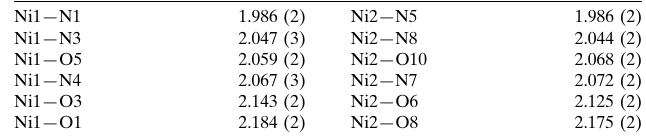
parameter ratio = 14.2. The asymmetric unit of the title compound, [Ni(C H N )(H O)] (cid:1) 1.25H O, contains two independent chemi- (C 10 8 2 2 2 cally identical Ni II complex cations and two and a half solvent water molecules. The Ni II ions are in slightly distorted coordination environments. In the crystal structure, inter- molecular O—H (cid:1) (cid:1) (cid:1) O and weak C—H (cid:1) (cid:1) (cid:1) O hydrogen bonds link cations and water molecules into a three-dimensional network. One of the three uncoordinated water molecules is half-occupied.